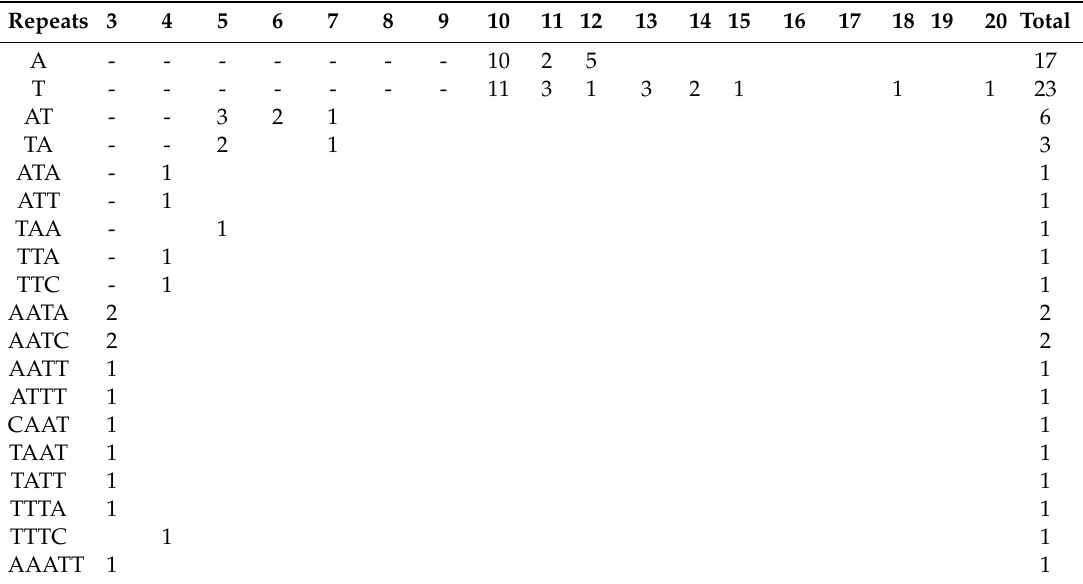
Table 2. Microsatellites in Artemisia scoparia